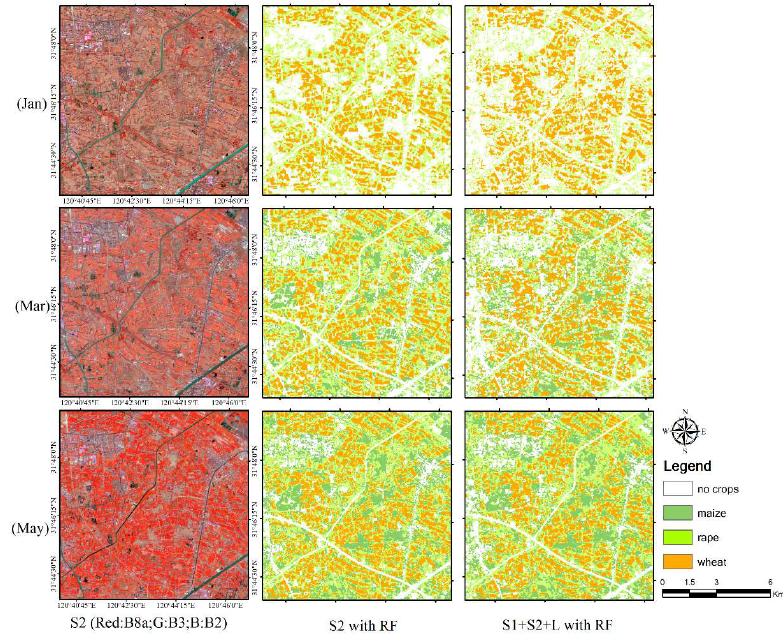
Figure 11. The best classification results of single and multi-resource data in January, March, and May 2018.